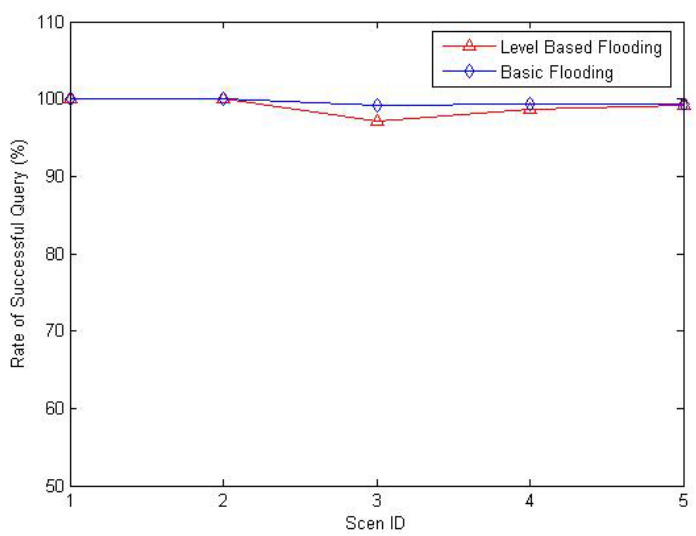
Figure 27. Ratio of successful query.